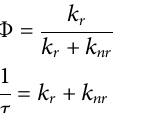
FIGURE 7 | Emission decay dynamics curve of the AuNCs diluted by pure water (v:v (cid:1) 1:10), without and with Fe(III) (100 μ M).